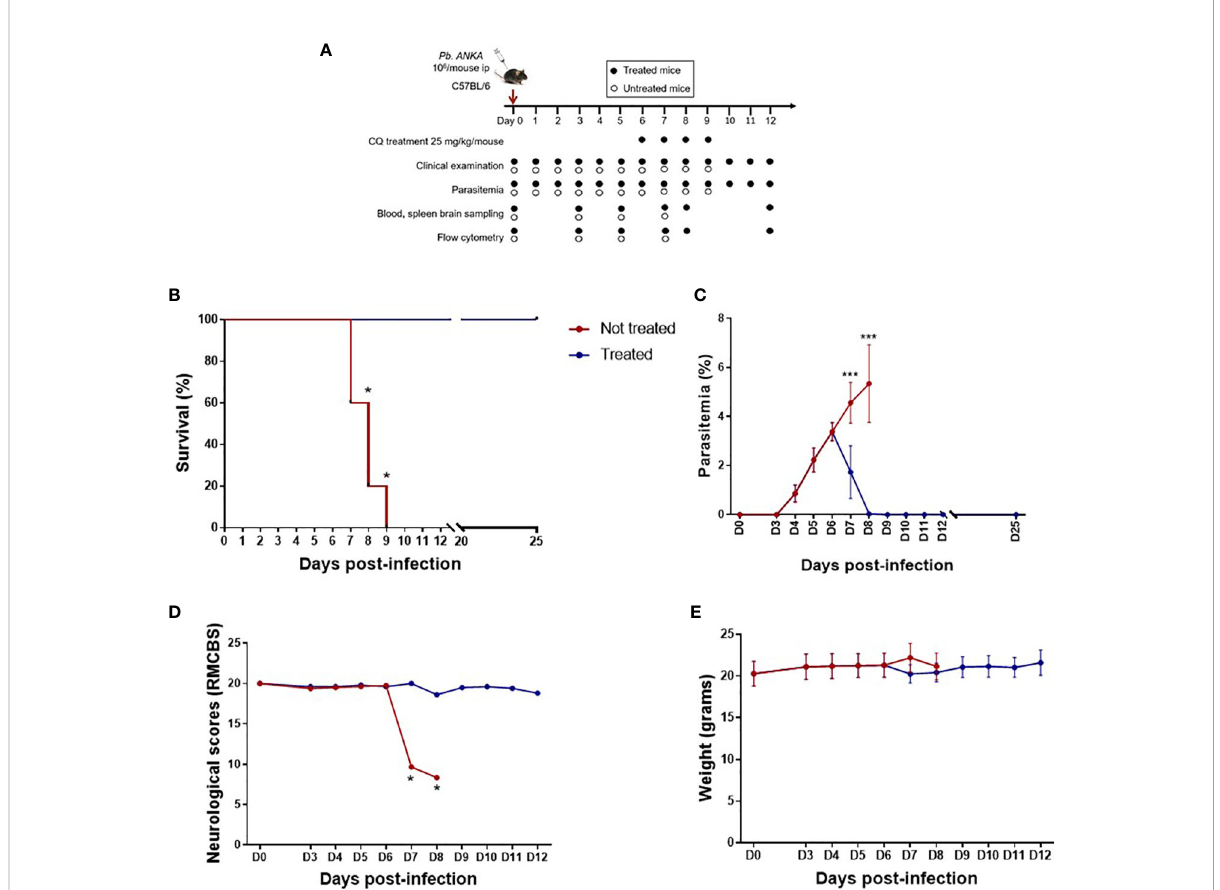
FIGURE 1 Late treatment with chloroquine (CQ) prolongs survival and limits parasitemia and neurological damage. (A) Plasmodium berghei ANKA-infected C57BL/6 mice treated intraperitoneally from day 6 (D6) to D9 post-infection with 25 mg kg − 1 day − 1 CQ and followed by clinical and parasitological examination, organ sampling, and fl ow cytometry analysis. (B) Survival curve in treated and untreated mice. (C) Course of parasitemia in treated and untreated mice. (D) Rapid murine cerebral behavior scale (RMCBS) scores during the course of infection in treated and untreated mice. (E) Weight of treated and untreated mice. Treated and untreated mice were compared for all parameters on D7, D8,